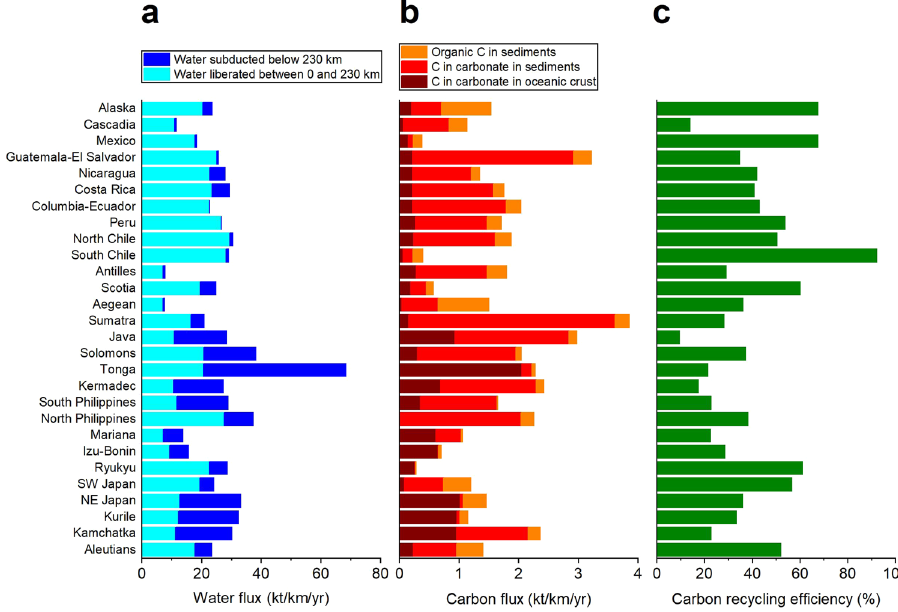
Fig. 3 Heterogeneity of subduction zone compositions and processes. Differences in water 2 ( a ) and carbon 3,4 ( b ) fl ux among subduction zones and corresponding C recycling ef fi ciency ( c ). The water fl ux estimates assume moderate mantle hydration 2